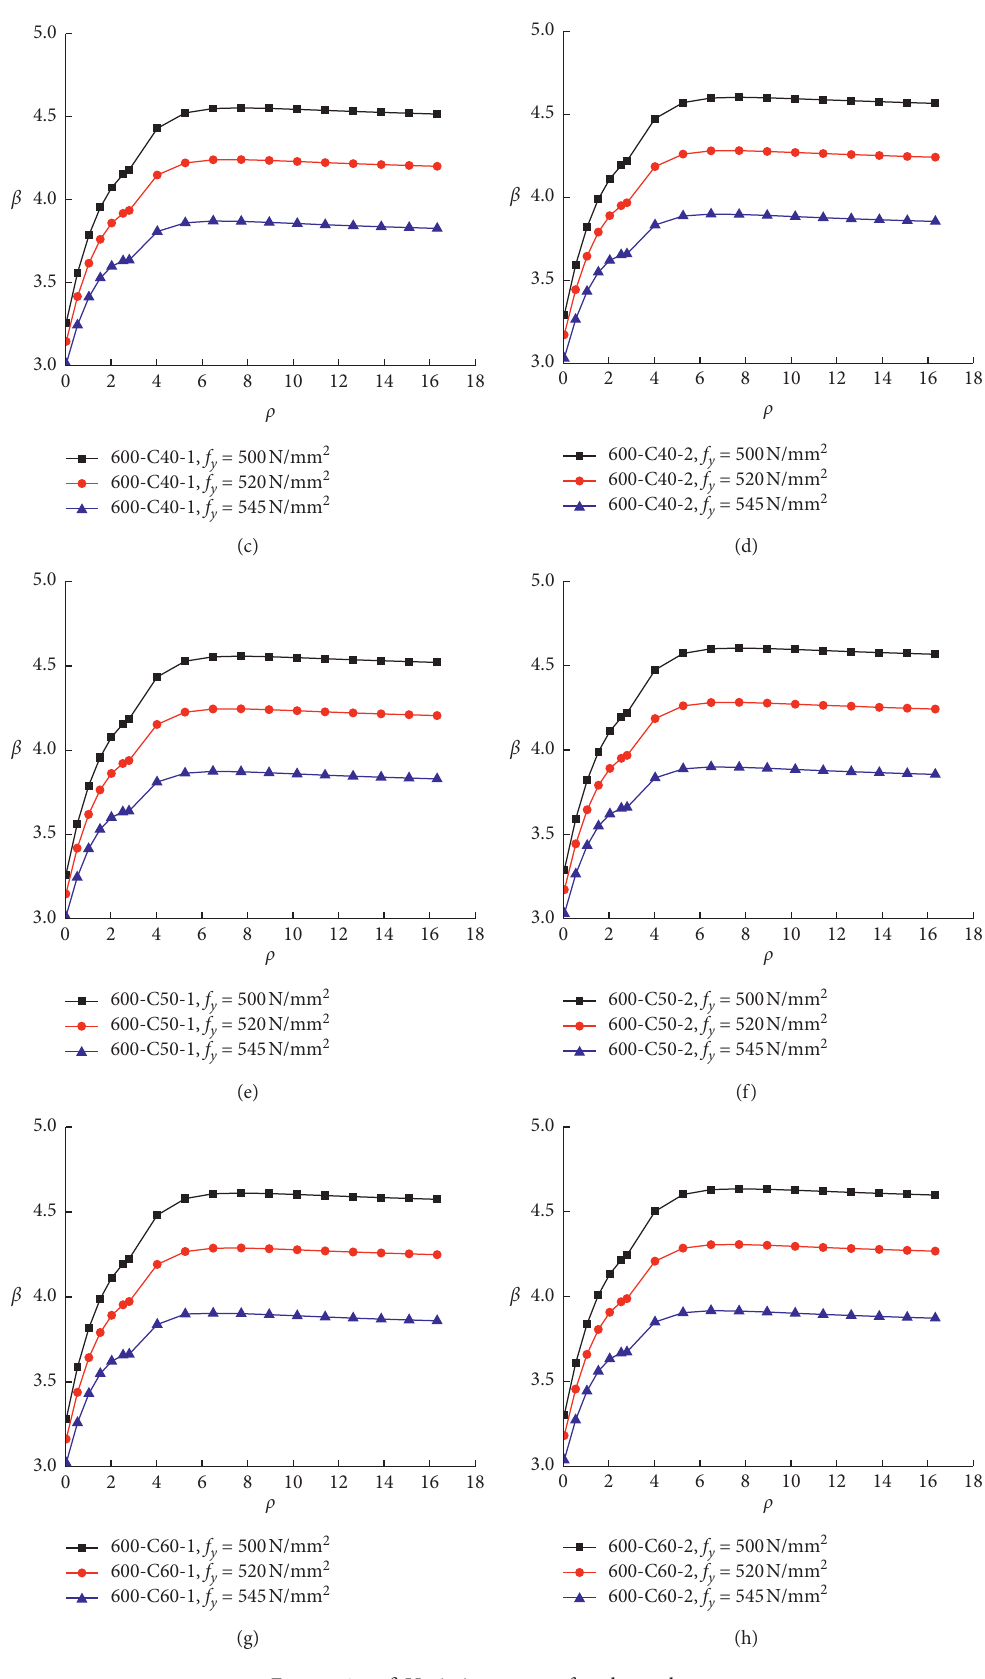
Figure 9: ρ - β Variation curve of each test